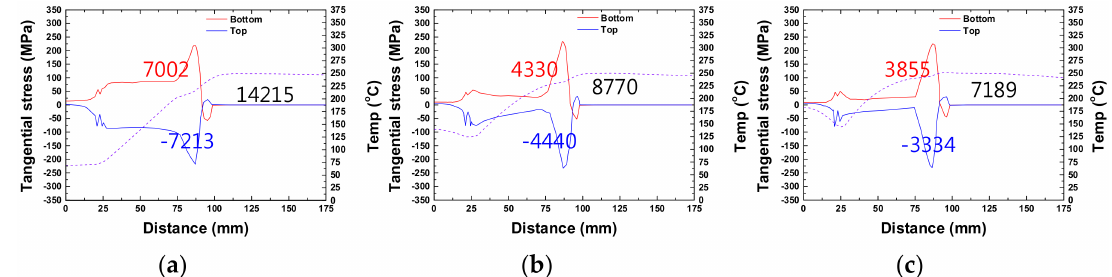
Figure 9. The tangential stress values at the top and bottom layers of the blank (under non-isothermal condition) for punch speeds of ( a ) 1, ( b ) 5 and ( c ) 10 mm/s at 250 ◦ C. The dotted curves represent the temperature profile along the center of the cross-section of the sheet.